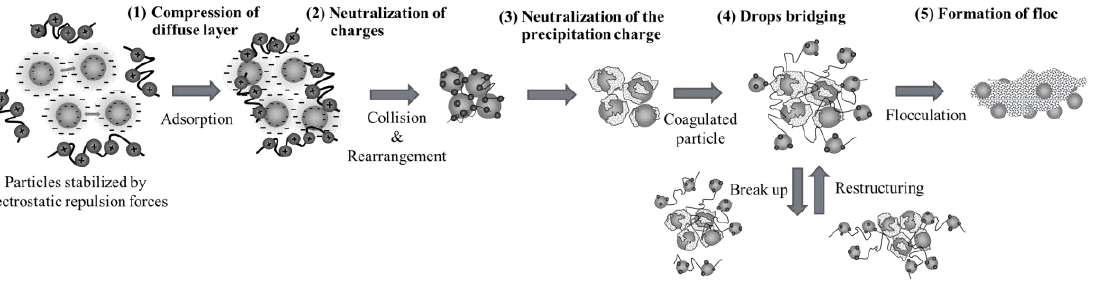
Figure 3. Coagulation and/or destabilization